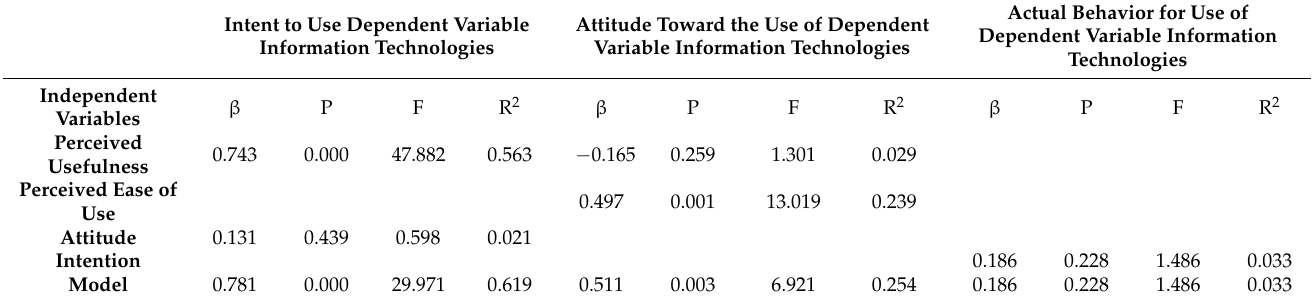
Table 6. Regression analysis